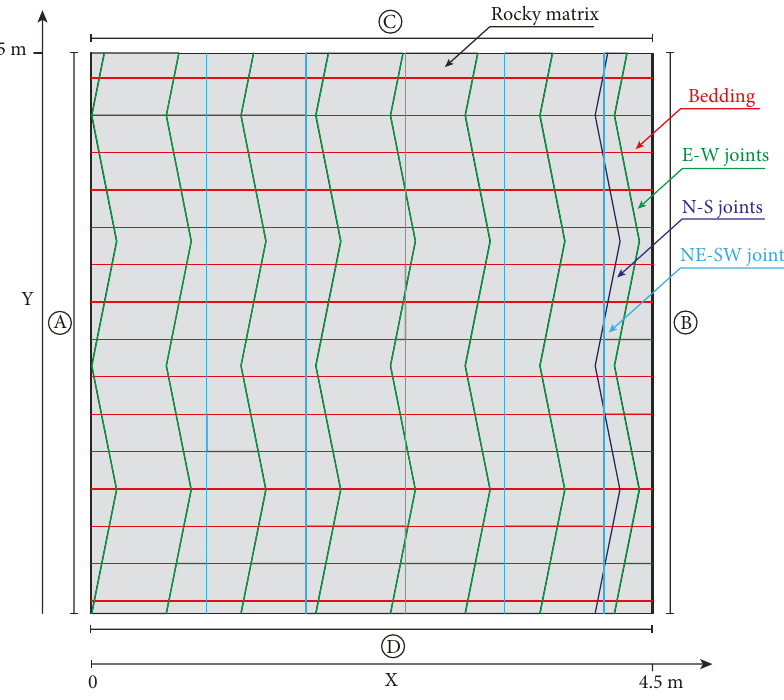
Figure 6: Scheme of the REV ’ s discrete fracture network investigated by numerical